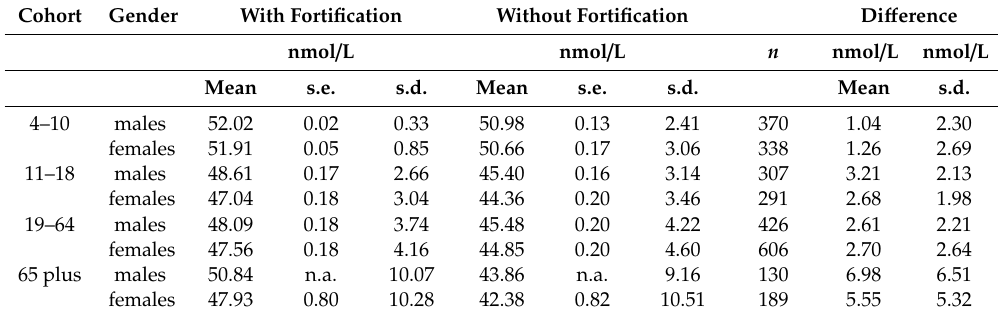
Table 5. Calculated (via mathematical modeling) serum concentrations of 25(OH)D after consumption of fortified ready-to-eat cereals (RTEC) by 4.2 µ g / 100 g, applying the amount consumed as documented in the NDNS database, keeping the amount of UV exposure constant. Only RTEC consumers used. With Fortification Without